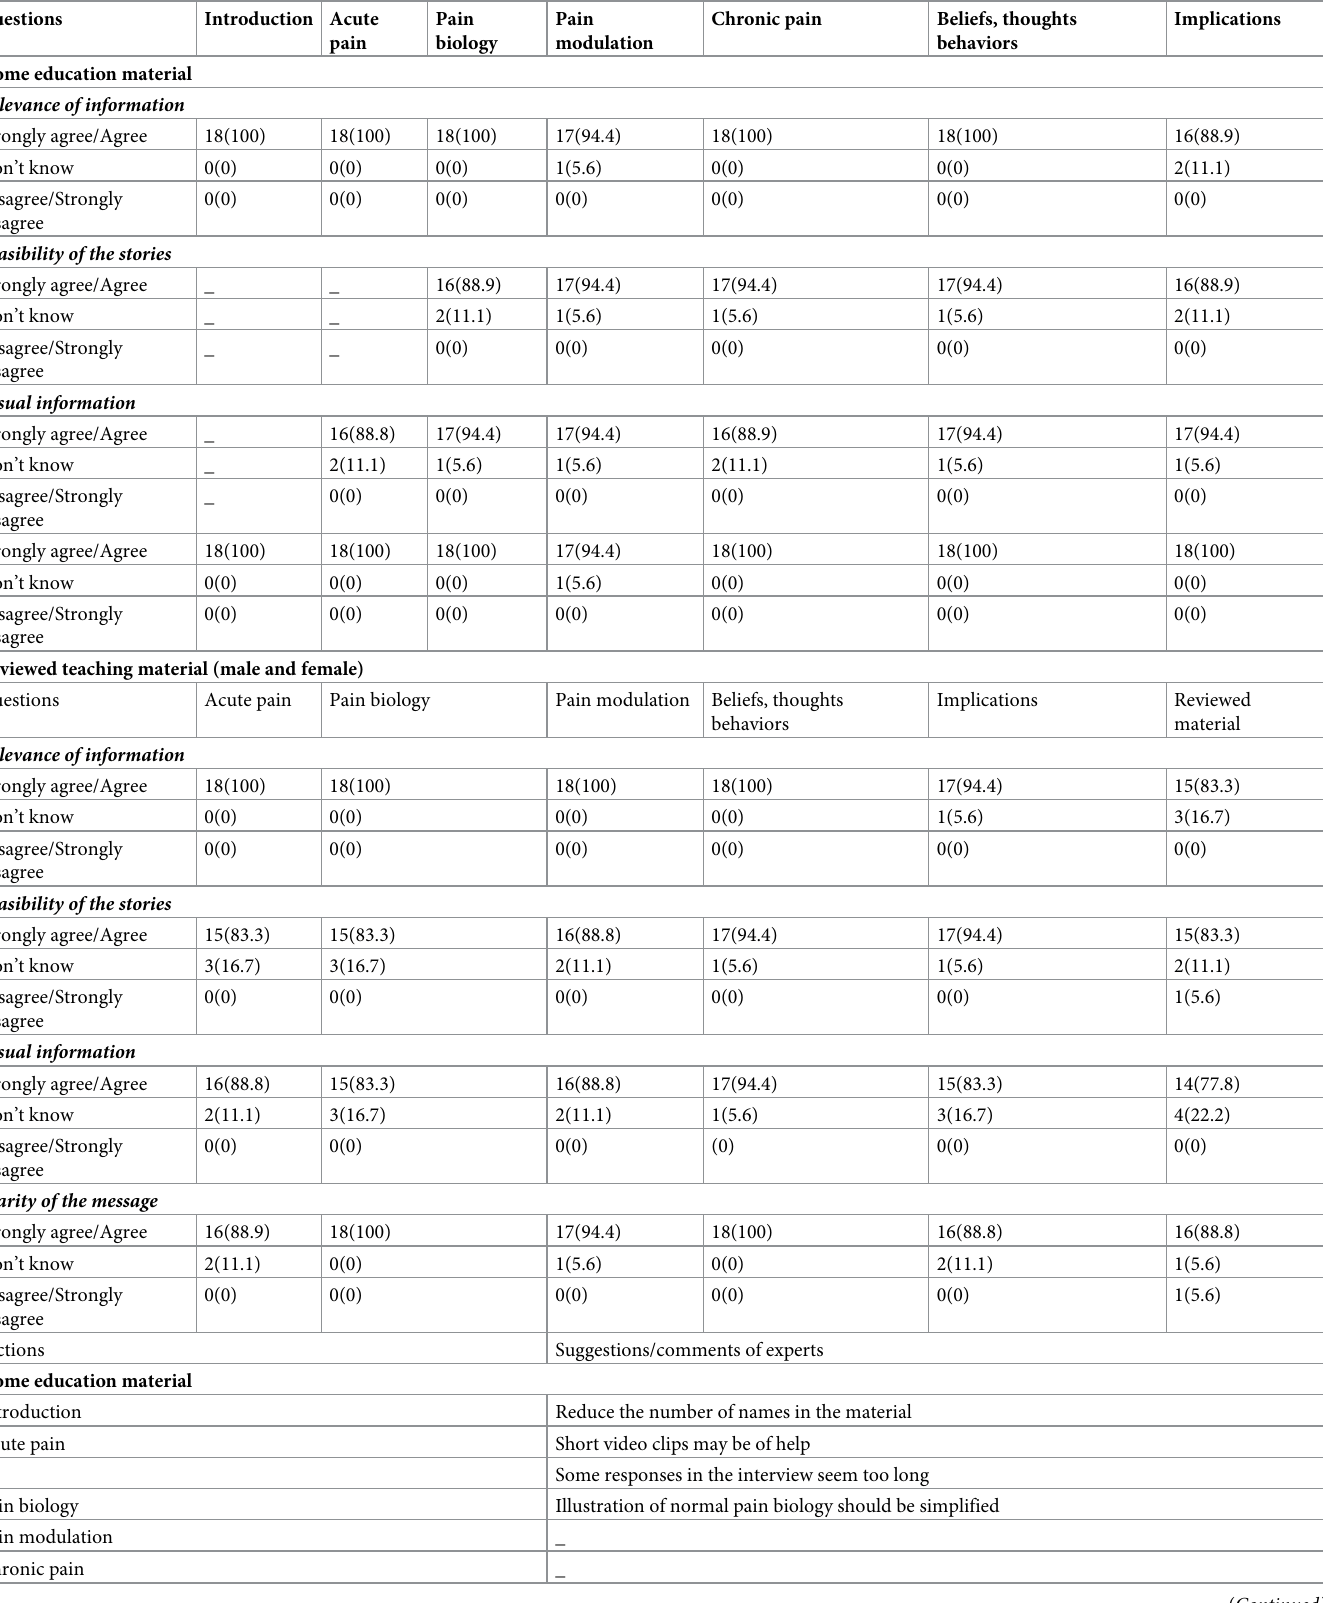
Table 4. Results and responses of the Delphi round 2 for the home education material and the reviewed teaching materials (n =